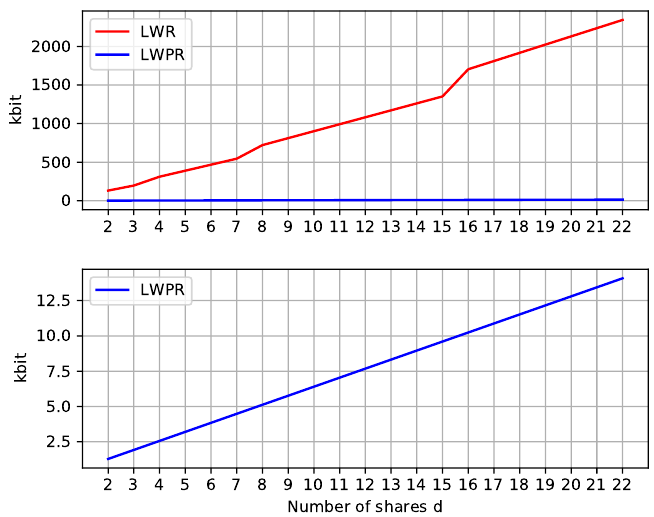
Figure 8: Randomness requirements in function of the number of shares.